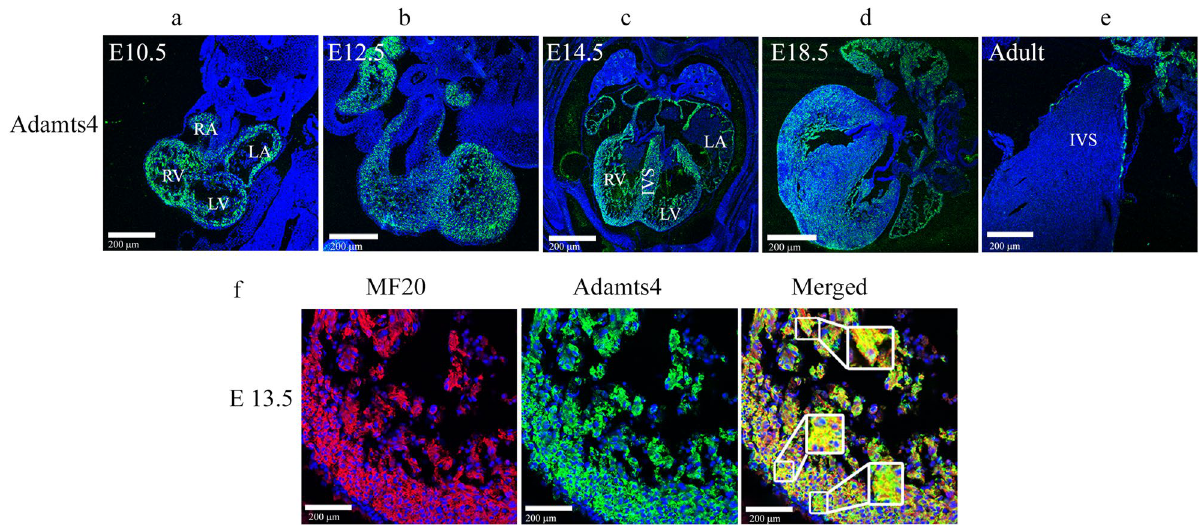
Figure 1. Dynamic expression of Adamts4 protein in embryonic and adult heart. Adamts4 expression is shown in developing E10.5 ( a ), E12.5 ( b ), E14.5 ( c ), E18.5 ( d ) adult ( e ) murine hearts. IHC with anti-Adamts4 antibody (green colour) and Topro3 (blue colour) used as nuclear stain, the expression pattern of Adamts4 is observed in ( a )–( e ). While the expression pattern of Adamts4 is more widespread in the embryonic stages throughout the RA, LA, RV, LV and IVS ( a – d ), the expression drastically reduces and is mainly only confined at the IVS in the adult stage ( e ) displaying a sharp contrast between the expression of Adamts4 in developing and adult stages. ( f ) Highlights the colocalization of Adamts4 (green) in the chamber myocardium with E13.5 chamber cardiomyocytes shows colocalization of Adamts4 with MF20 (shown in yellow colour) across the LV of